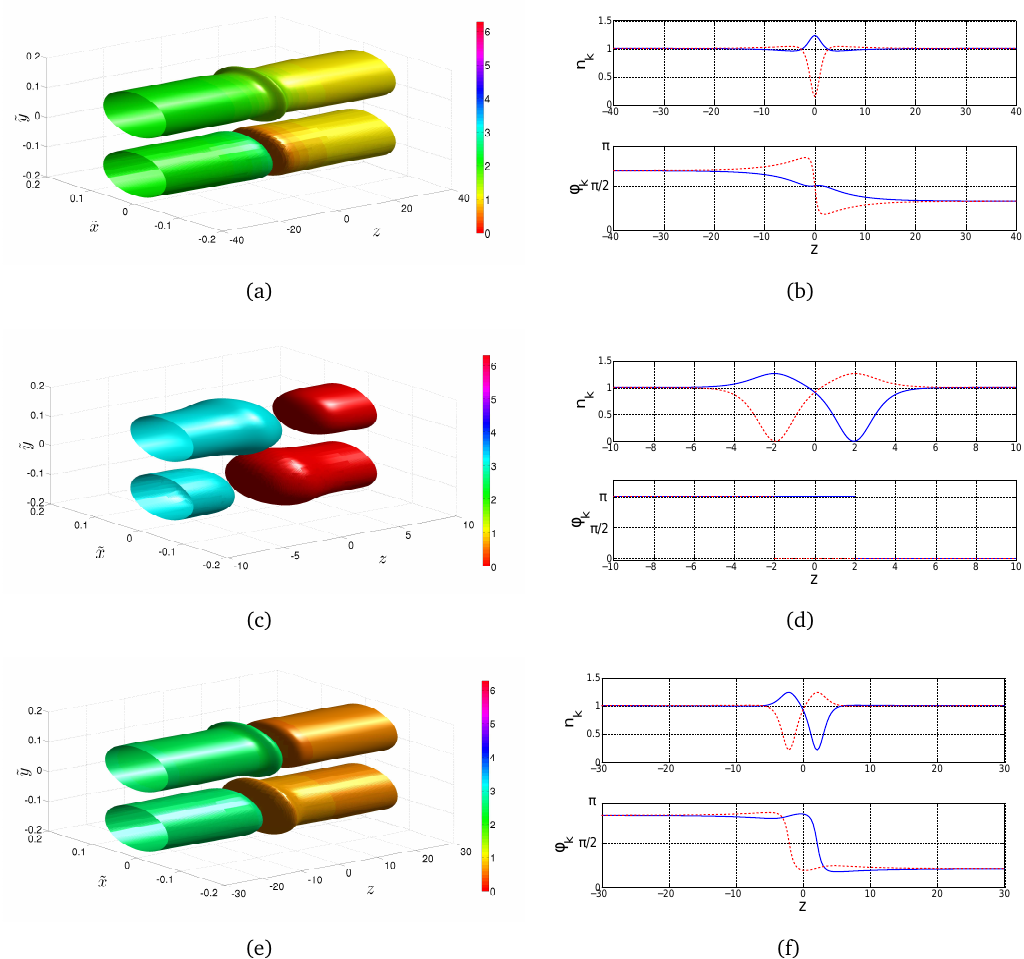
Figure 4: Numerical solutions from the Josephson vortex family corresponding to var- ious points of interest on the dispersion relations of Fig. 5. Left column: The density ( z ) = | ψ ( z ) | 2 is encoded in the width of the tube and the phase arg [ ψ ( z )] in the n k k k colour. The upper tube corresponds to component 1 and the lower one to component 2. ( z , ˜ x , ˜ y ) = n ( z ) exp [ − ( ˜ y ± 0.1 ) 2 + ˜ x 2 ] and plot isosurfaces at the value Specifically we define N k k 0.1 2 = 0.6. Right column: density (top panels) and phase (bottom panels) profiles are shown N k directly as a blue dashed line (component 1) and a red dashed line (component 2). (a) = 0.49 π , (c) & (d) stationary & (b) moving Josephson vortex: γ = 0.5, ν = 0.005, P c = 2.01 π , (e) & (f) moving staggered soliton: staggered soliton: γ = 0.5, ν = 0.005, P c γ = 0.5, ν = 0.005, P = 0.86 π c